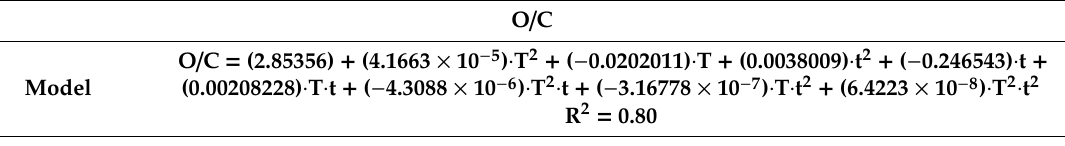
Table A13. The statistical parameters of polynomial regression analysis of the influence of SS torrefaction temperature and residence time on the O / C ratio in